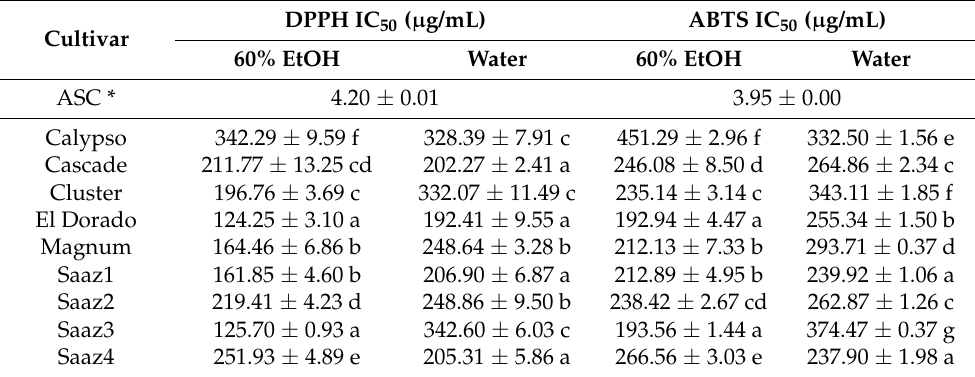
Table 3. Comparison of the antioxidant activities by 1,1-Diphenyl-2-picrylhydrazyl free radical scavenging assay (DPPH) and 2,2-Azino-bis-3-ethylbenzothiazoline-6-sulfonic acid assay (ABTS) of hop strobile